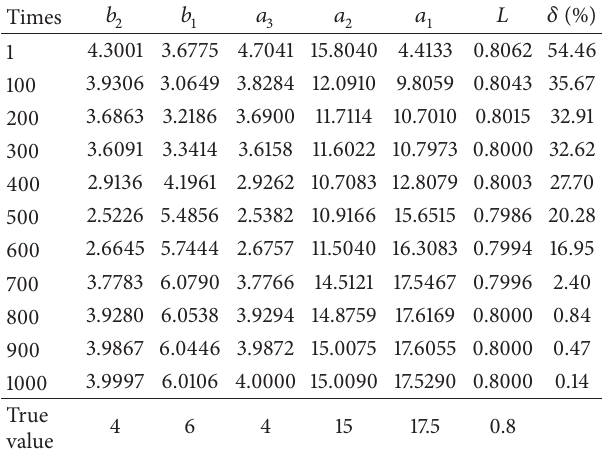
Figure 2: The error 𝛿 of parameters estimation versus Times . Table 1: Estimation of parameters.